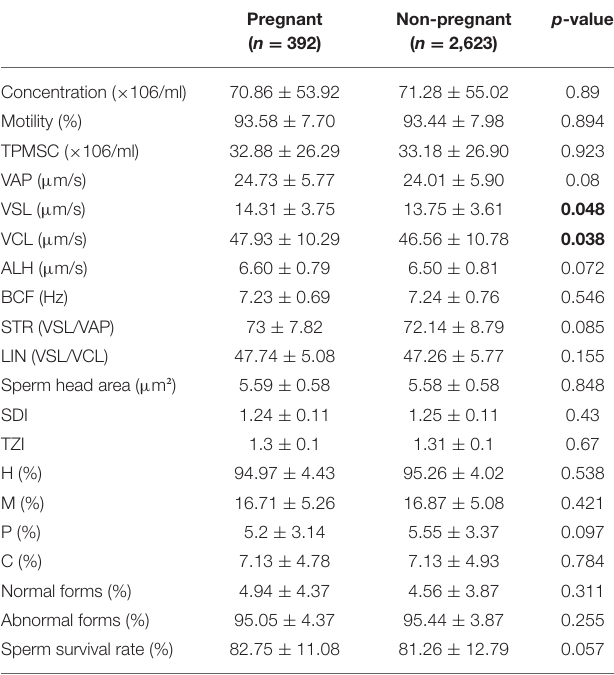
TABLE 2 | Comparison of sperm parameters between pregnant and non-pregnant groups.